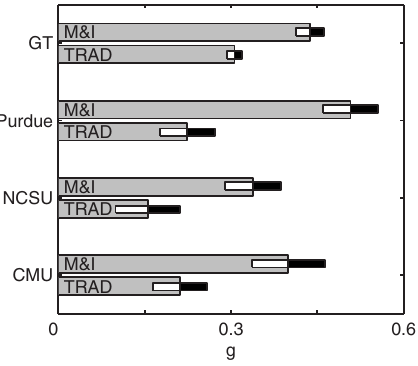
FIG. 3. Gain in student understanding of E&M at four academic institutions—the increase in student understanding resulting from a one-semester traditional (cid:1) TRAD (cid:2) or M&I course is measured using the average normalized gain g . The numbers of students tested for each curriculum at each institution: GT M&I: N =297; GT Trad.: N =887; Purdue M&I: N =76; Purdue Trad.: N =79; NCSU M&I: N =79; NCSU Trad.: N =48; CMU M&I: N =73; and CMU Trad.: N =116. The error bounds represent the 95% confidence intervals on the estimate of the normalized gain. The estimates of g require the average BEMA scores for incoming students I ; for the NCSU and CMU results, I was computed differently than for the GT and Pur- due results (cid:1) see Secs. II, V, and VI for details (cid:2)